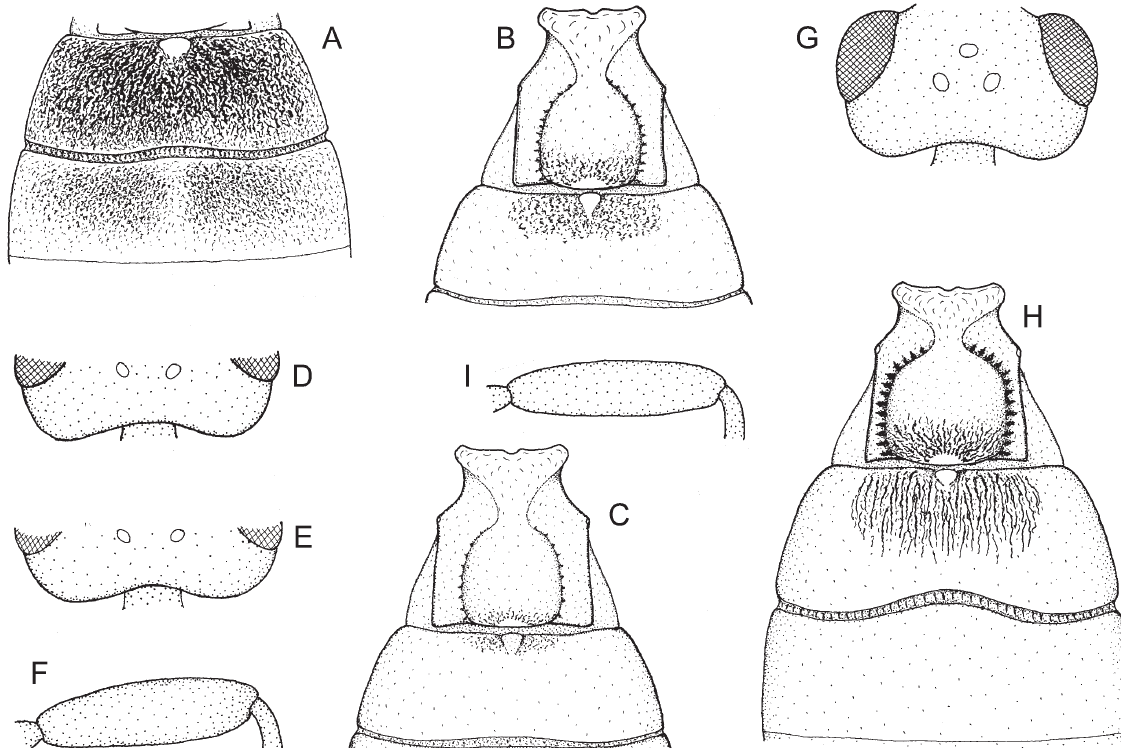
Fig. 64. — A-F . Bracon ( Glabrobracon ) immutator Nees, 1834 (A-B, D-F: ♀ / ♂, C: ♀). A . Tergites 2-3. B-C . Tergites 1-2. D-E . Hind half of head in dorsal view. F . Hind femur. — G-I . Bracon ( Glabrobracon ) pulcher Bengtsson, 1924, ♀ / ♂ paralectotype. G . Head in dorsal view. H . Tergites 1-3. I . Hind